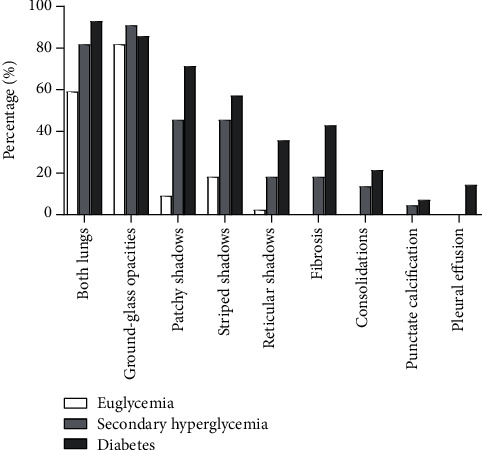
The frequency of evaluated CT imaging features in three groups.